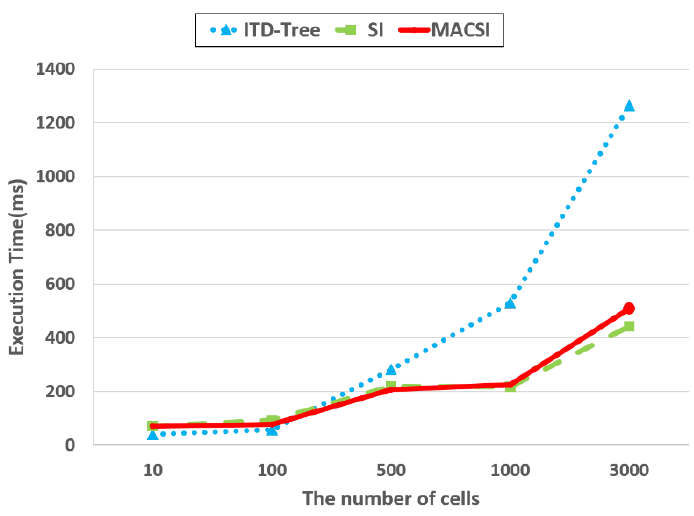
Figure 24. The effect of cell number on the coarse-grained semantic object query performance.